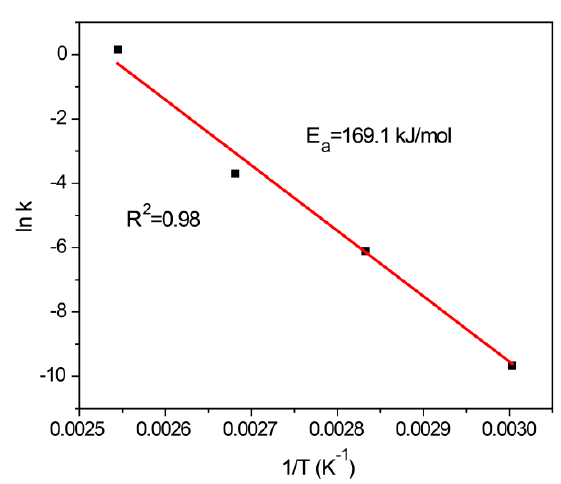
Figure 11. ln (1/1 − x) versus reaction time in di ff erent temperature.